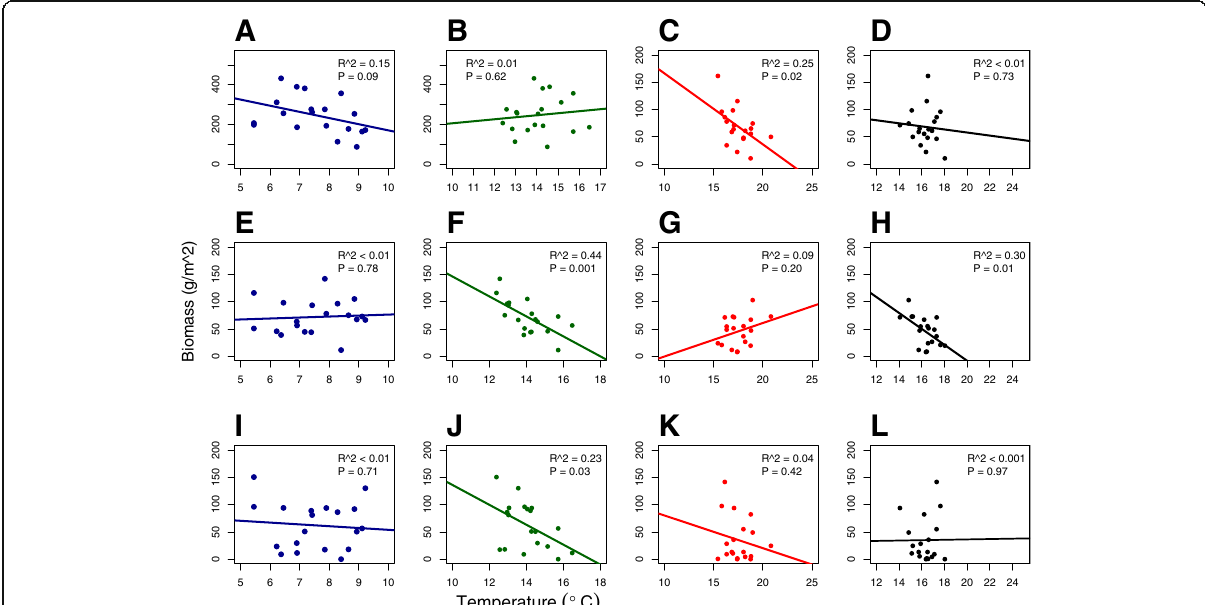
Fig. 8 Response of functional group aboveground biomass productivity to early and late growing temperature in June and September. Relationships of aboveground biomass productivity of the functional group of grasses with early growing season (16 March – 30 April) temperature in June ( a ), late growing season (01 May – 15 June) temperature in June ( b ), early growing season (16 June – 31 July) temperature in September ( c ), and late growing season (01 August – 15 September) temperature in September ( d ) harvests. Relationships of aboveground biomass productivity of the functional group of herbs with early growing season temperature in June ( e ), late growing season temperature in June ( f ), early growing season temperature in September ( g ), and late growing season temperature September ( h ) harvests. Relationships of aboveground biomass productivity of the functional group of legumes with early growing season temperature in June ( i ), late growing season temperature in June ( j ), early growing season temperature in September ( k ), and late growing season temperature September ( l